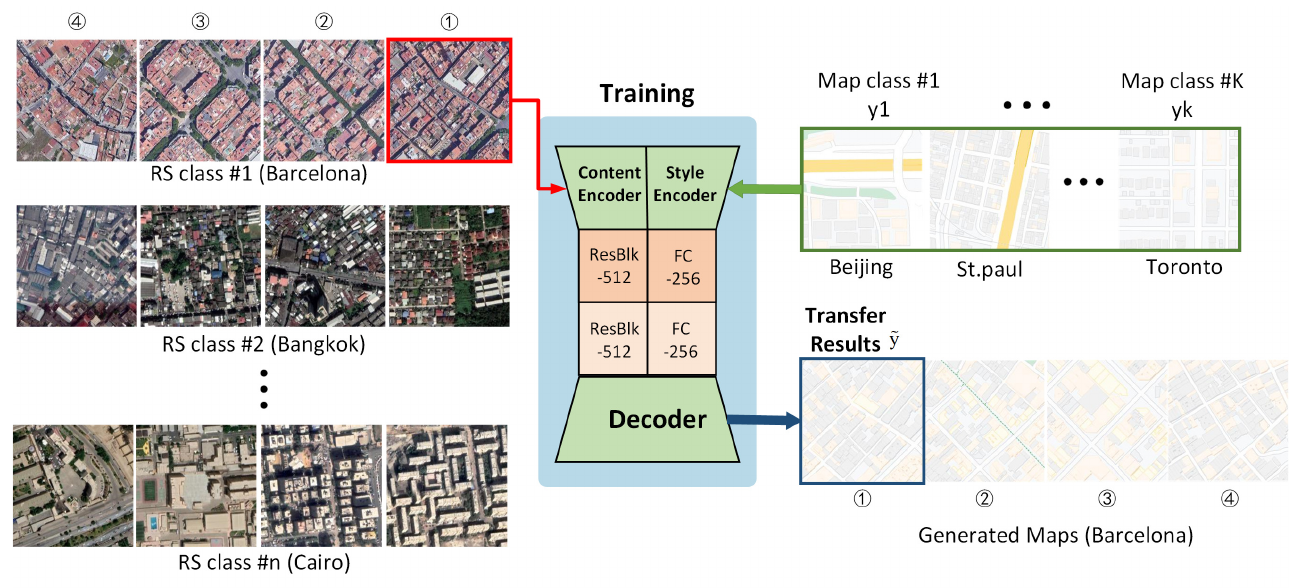
Figure 3. The flow path of RSMT training. The training set consists of paired remote sensing images and maps of various regions, like Barcelona, Bangkok, ..., Cairo (In this work, we use 12 cities’ remote sensing images and maps as the training set). The generator takes two inputs: one is a remote sensing image, the other is a set of K random maps { y 1 , y 2 , . . . , y K } obtained from map classes. The model aims to transfer the generation pattern to the unseen remote sensing images and generate realistic maps during testing. FC is the fully connection